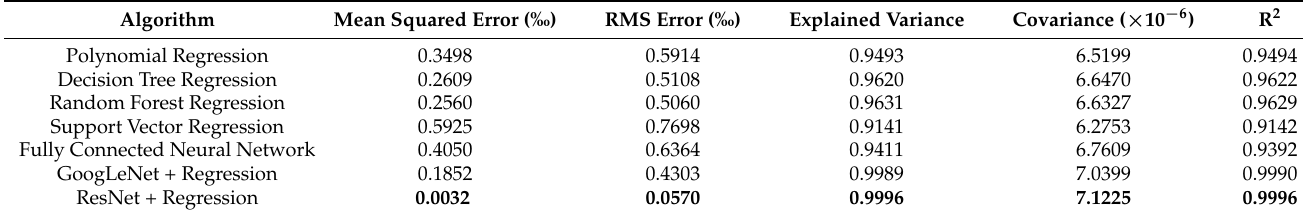
Table 2. Benchmark